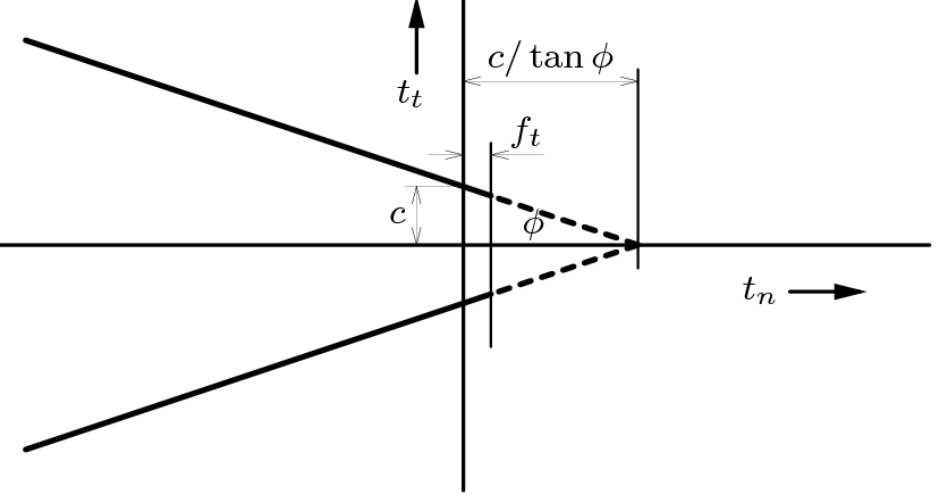
Figure 6. Coulomb friction model [36].